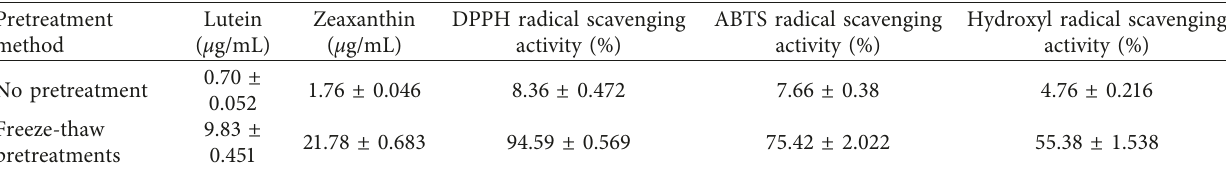
Figure 5: Transmission electron microscope (TEM) images of CGM. (A1, A2) no pretreatment; (B1, B2) freeze-thaw ( − 20 ° C, 100% moisture content, freeze-thaw twice) pretreatment. Table 1: Lutein and zeaxanthin content and scavenging activity of the CGM with and without pretreatment. Data represent the mean value ± standard deviation ( n �